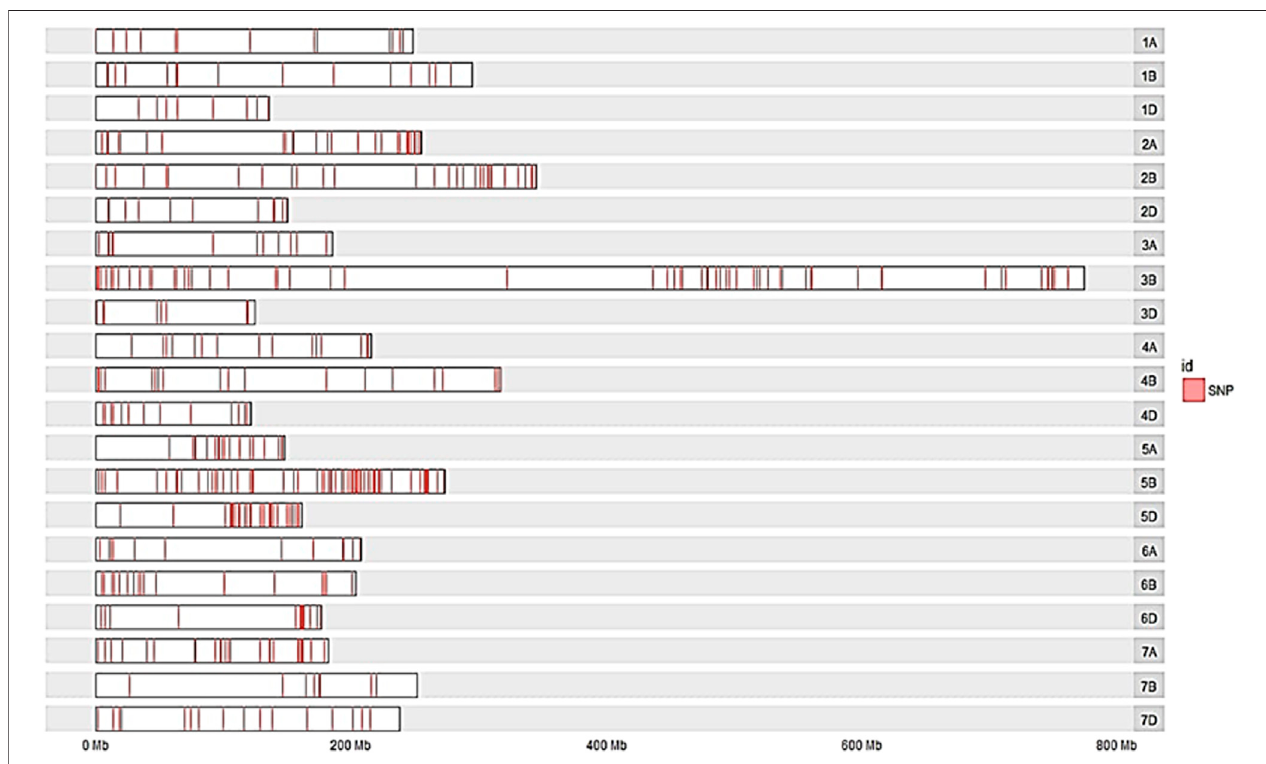
FIGURE 3 | Bar plot showing the densities of polymorphic SNPs marker with bulk frequency ratio greater than 6 (BFR > 6) on the 21 wheat chromosomes of the cross “ YS#24×YS#58 ” RILpopulation.ThelocationsoftheSNPsweredeterminedbythebestalignmenttothewheatgenomewiththetranscriptcontainingtheSNPs.